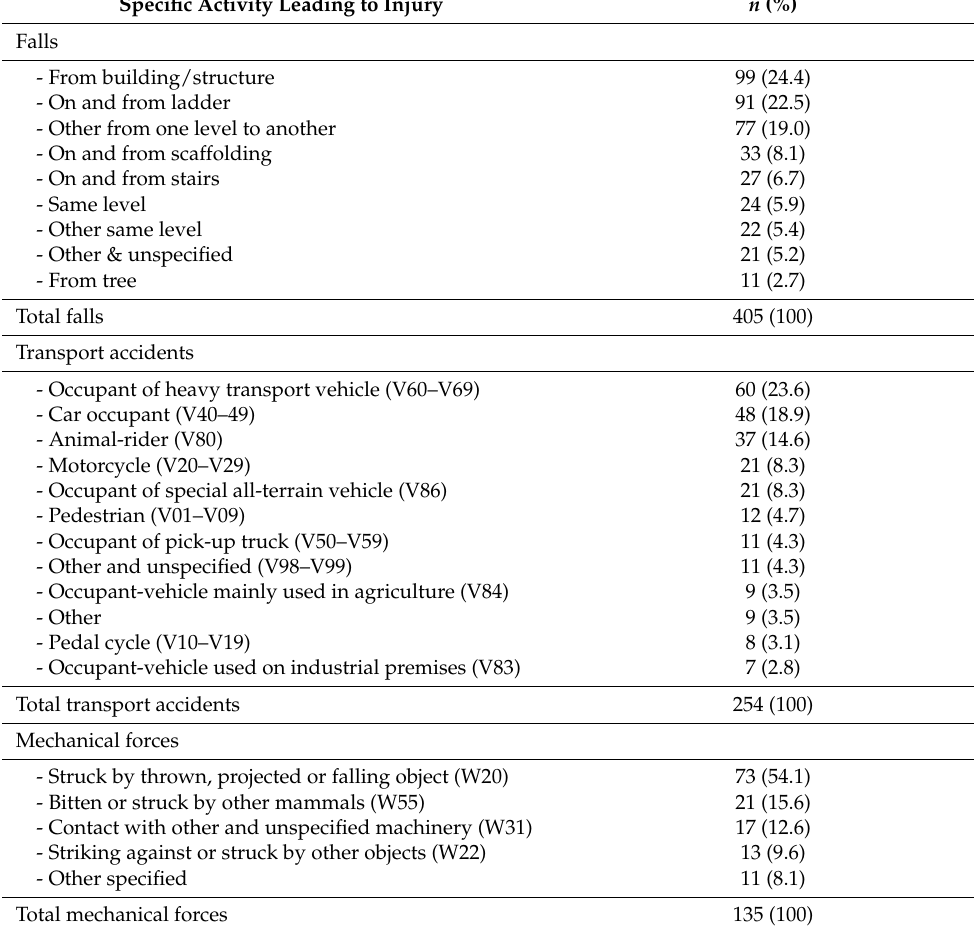
Table 3. A detailed description of injury in the context of